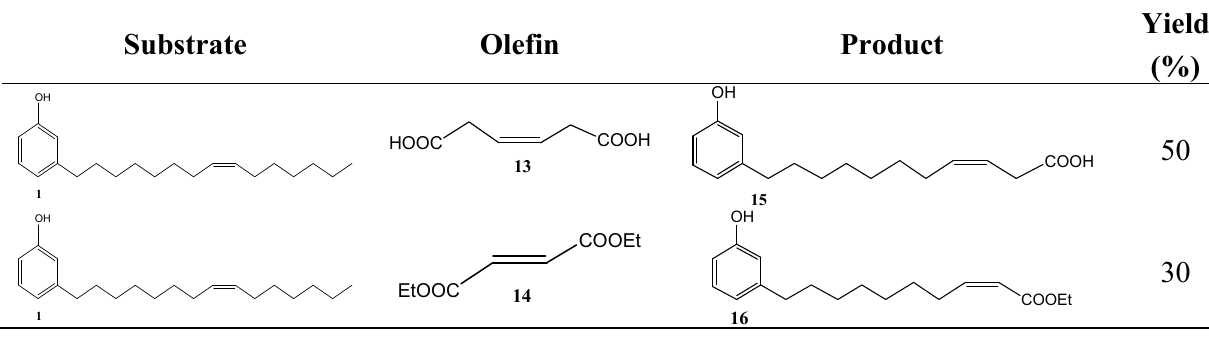
Table 2. Cross-metathesis reaction involving